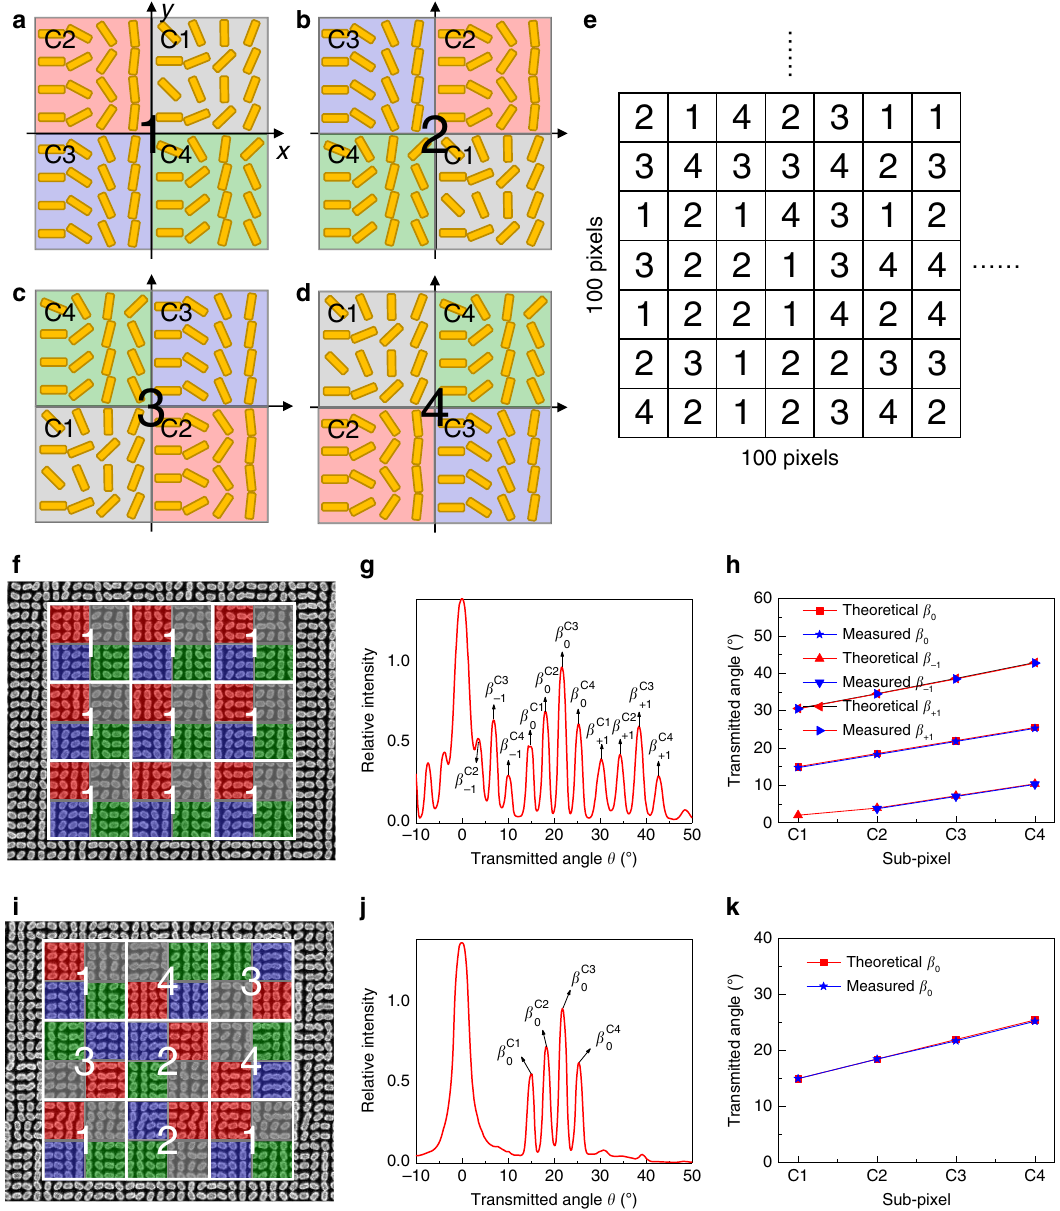
Fig. 3 Uniformly and randomly distributed subpixels. a – d The subpixels in one super-pixel are distributed with four different arrangement. e A 100 × 100 matrix with randomly distributed integer of 1, 2, 3, and 4 is generated using MATLAB. Each numeral is corresponding to the subpixels of ( a – d ). f A beam de fl ector is designed with subpixels uniformly distributed using con fi gurations shown in ( a ). The four subpixels C1, C2, C3, and C4 are designed with interested order at 15°, 18.5°, 22°, and 25.5°, respectively. g Measured far- fi eld intensity pattern shows that a series of grating orders β Cn m ( m = ±1, n = 1, 2, 3, 4) is generated. h Measured angles of the grating orders agree well to the simulated results. i A beam de fl ector design with randomly distributed subpixels based on the random matrix in ( e ). j Measured far- fi eld intensity pattern shows the grating order is destroyed due to a variable lattice constant d . k Only interested order is obtained without other grating